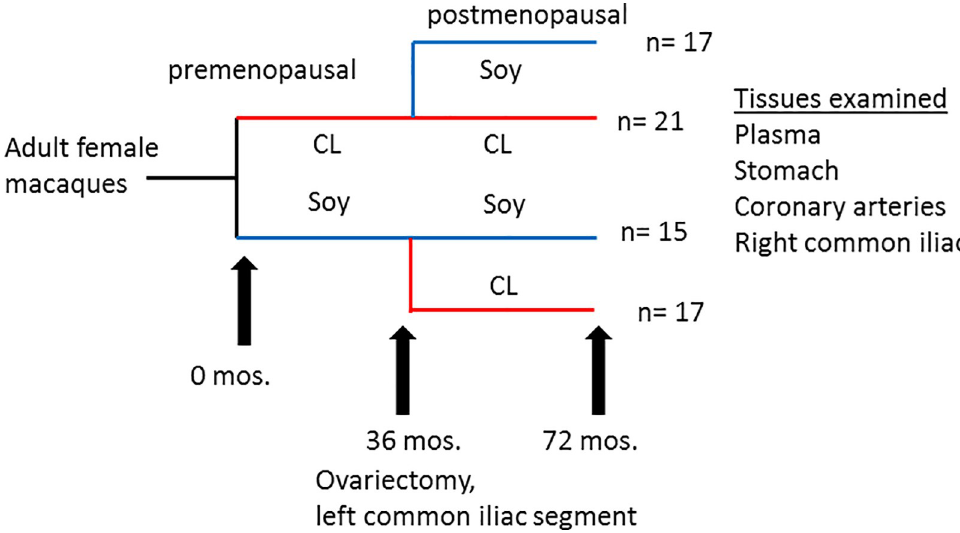
Fig 1. Study design. Cynomolgus macaques received either SOY or CL diets for 36 months, at which point animals were ovariectomized and a left common iliac segment was removed. Half of the animals received the alternate diet for an additional 36 months. The number (n) of surviving animals that could be classified as H . pylori -positive or–negative (70 out of 74) is given for each group.